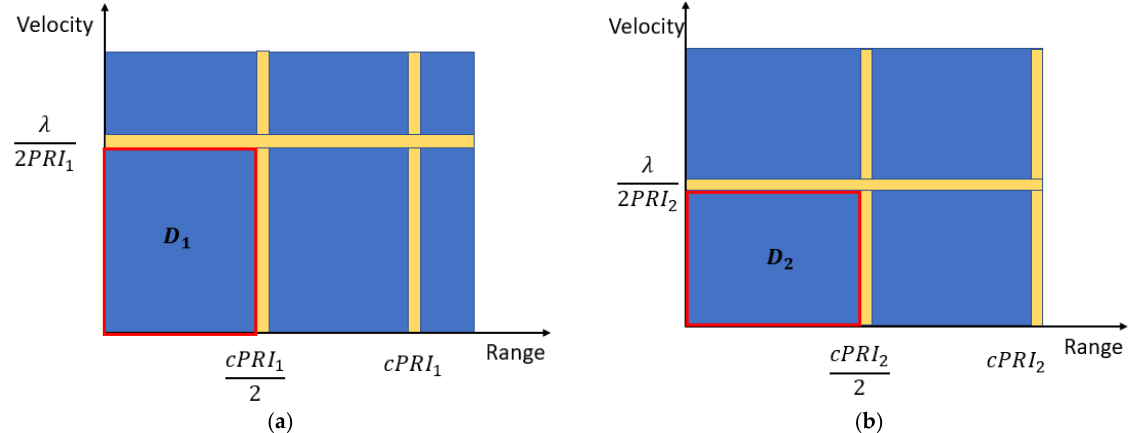
Figure 1. Visibility map of ( a ) PRI 1 ; ( b ) PRI 2 The common un-ambiguous region is the common domain of the un-ambiguous ranges and dopplers of all the dwells of the waveform.